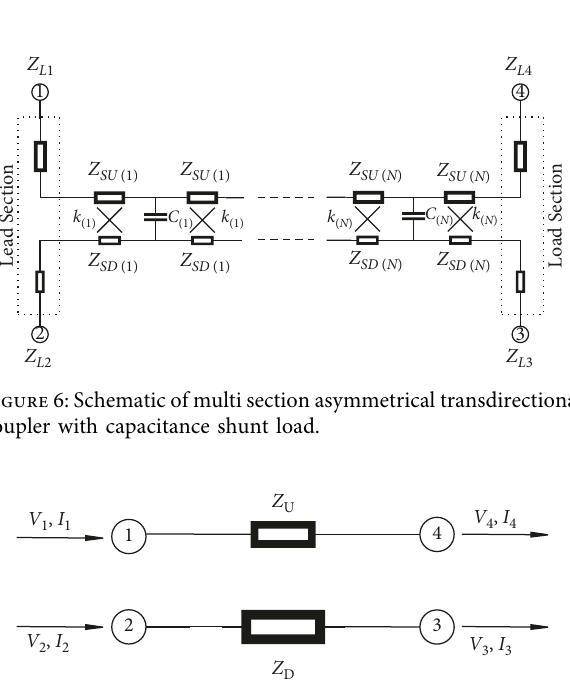
Figure 7: Schematic of lead/load